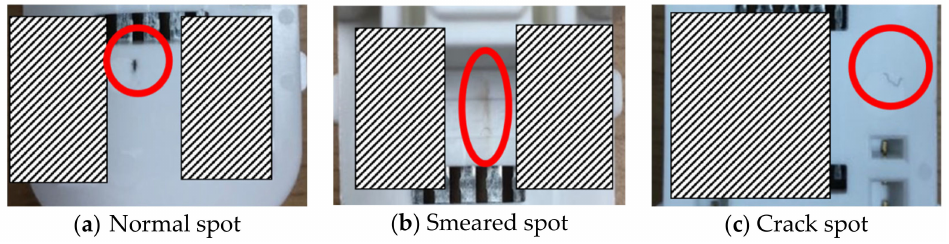
Figure 11. Three types of black spots.